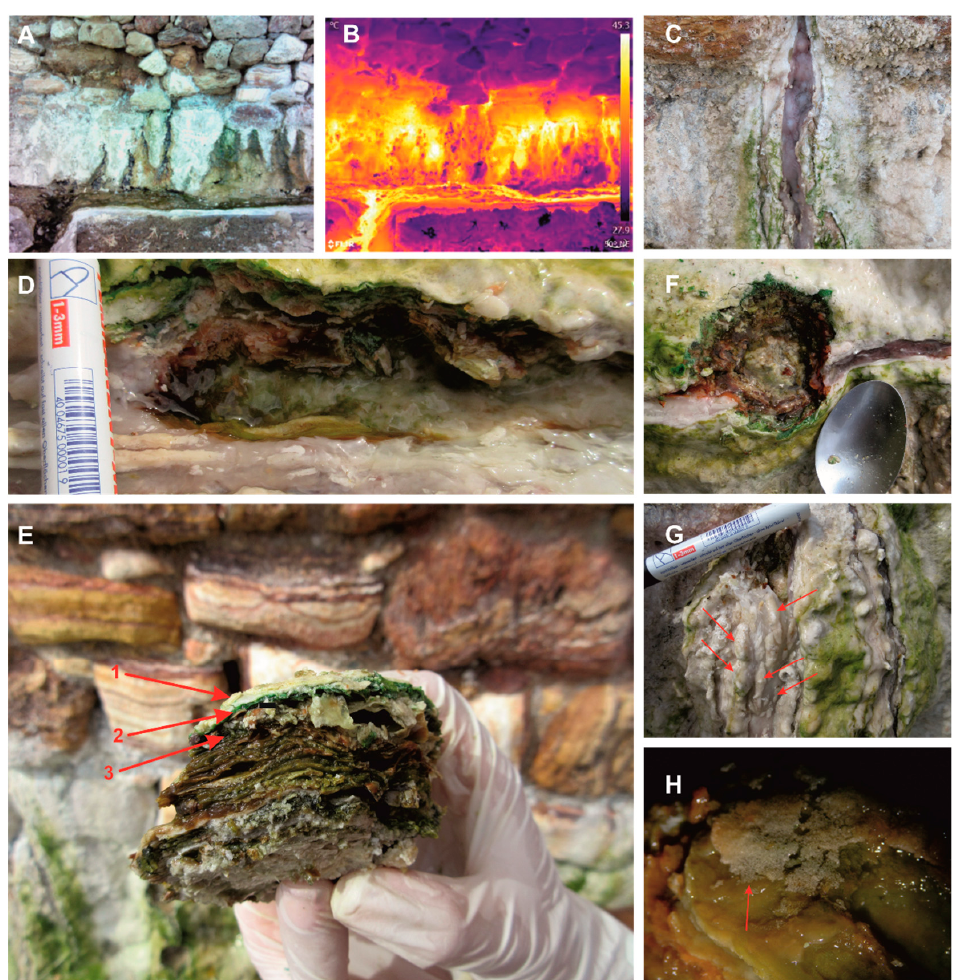
Figure 2. Field photos and sample photos. ( A , B ) Paired views of the study site. Normal image ( A ) and corresponding thermal image ( B ). On the right side of the thermal picture, a column shows the temperature scale (°C). ( C ) Detailed image of the hot water flow and the microbial mats. ( D ) A vertical cut of the microbial mats, displaying the different vertical layering. ( E ) A complete piece of microbial mats displaying the vertical stratification: (1) top layer-the abiotic layer of travertine (white color), (2) intense blue-green layer of Cyanobacteria, and (3) olive-green layer where there is a reduction of Cyanobacteria and presence of other bacteria. ( F ) Detailed image of the hot water flow and the microbial mats. ( G ) Parts of the top abiotic layer where dense white parts can be observed (arrows). ( H ) The top abiotic layer of micritic calcium carbonate minerals under a